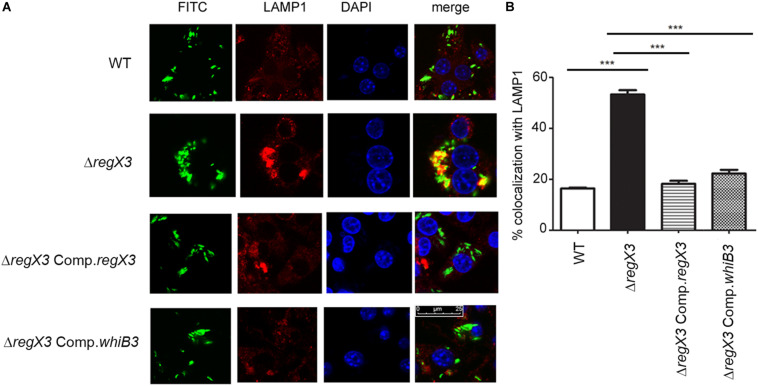
RegX3 and WhiB3 are required for trafficking of M. tuberculosis to lysosomes (A) RAW264.7 cells were infected with FITC-labeled (green) M. tuberculosis (WT, ΔregX3, ΔregX3 Comp.regX3 or ΔregX3 Comp.whiB3), fixed and immunolabeled with anti-LAMP1 followed by Alexa 546-conjugated secondary antibody (red). Cells were stained with DAPI to visualize the nuclei. Colocalization of green and red fluorescence indicates bacterial trafficking to the lysosomal compartment. (B) Percent colocalization of each of the four strains with LAMP1 was calculated by counting at least 100 bacteria from five different fields. Data represents means ± S.D., three independent experiments. ***p < 0.001.